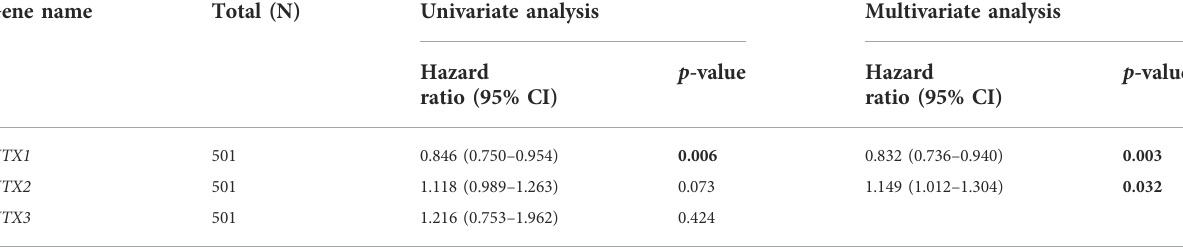
TABLE 2 Univariate and multivariate Cox analysis of PITX gene expression for determining HNSC